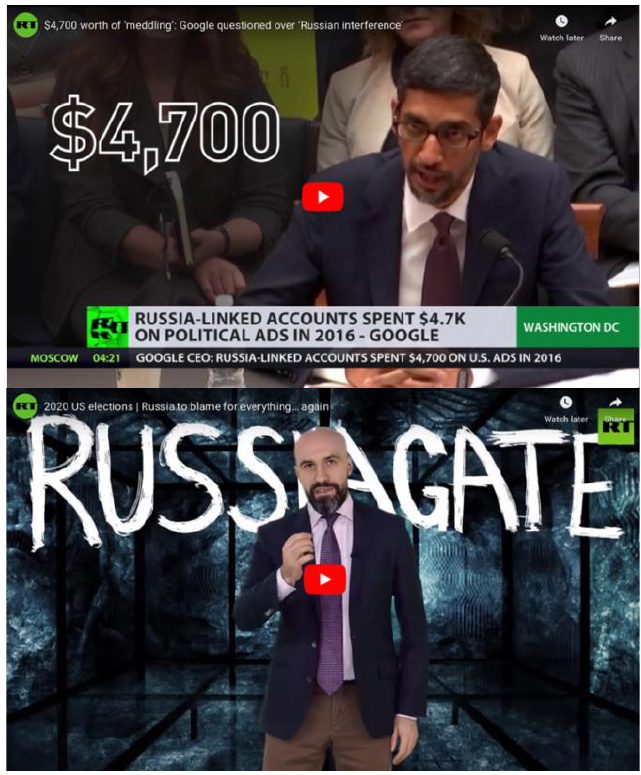
Figure 5. The RT videos shown to participants in our study . The top was used in the April 2020 survey and the bottom in the July. Click each to